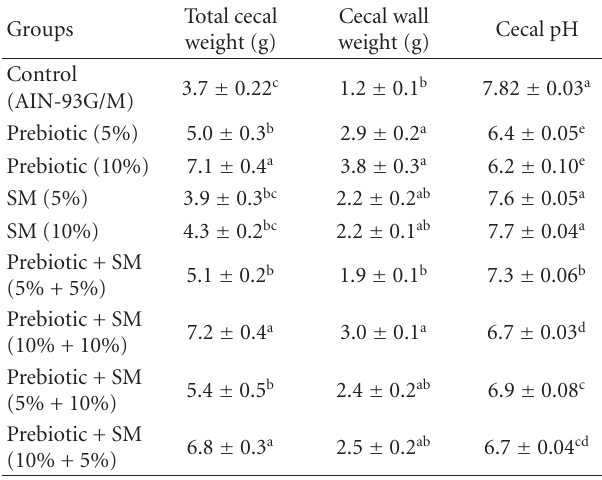
Abbreviations: SM: soybean meal. Values are expressed as means ± SEM.